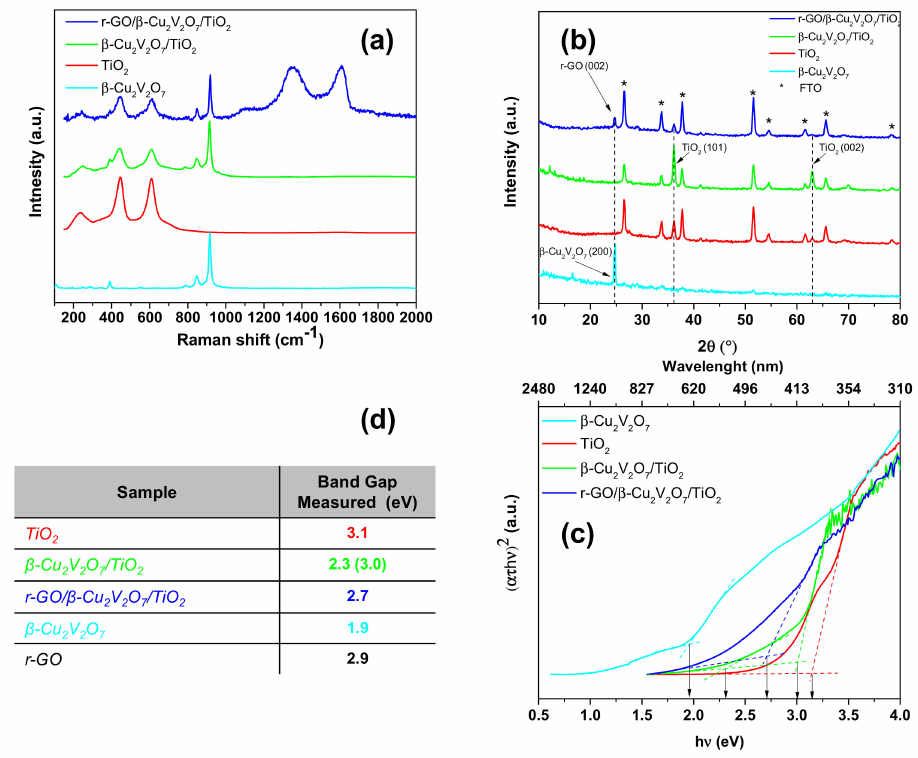
Figure 1. Raman spectra ( a ); wide angle X-ray diffraction (WAXD) patterns ( b ); and Tauc plots ( c ) of β -Cu β -Cu β -Cu 2 V 2 O 7 , TiO 2 NRs, 2 V 2 O 7 /TiO 2 and GO/ 2 V 2 O 7 /TiO 2 ; Bandgap values obtained from Tauc plots are indicated in the table on the left ( d